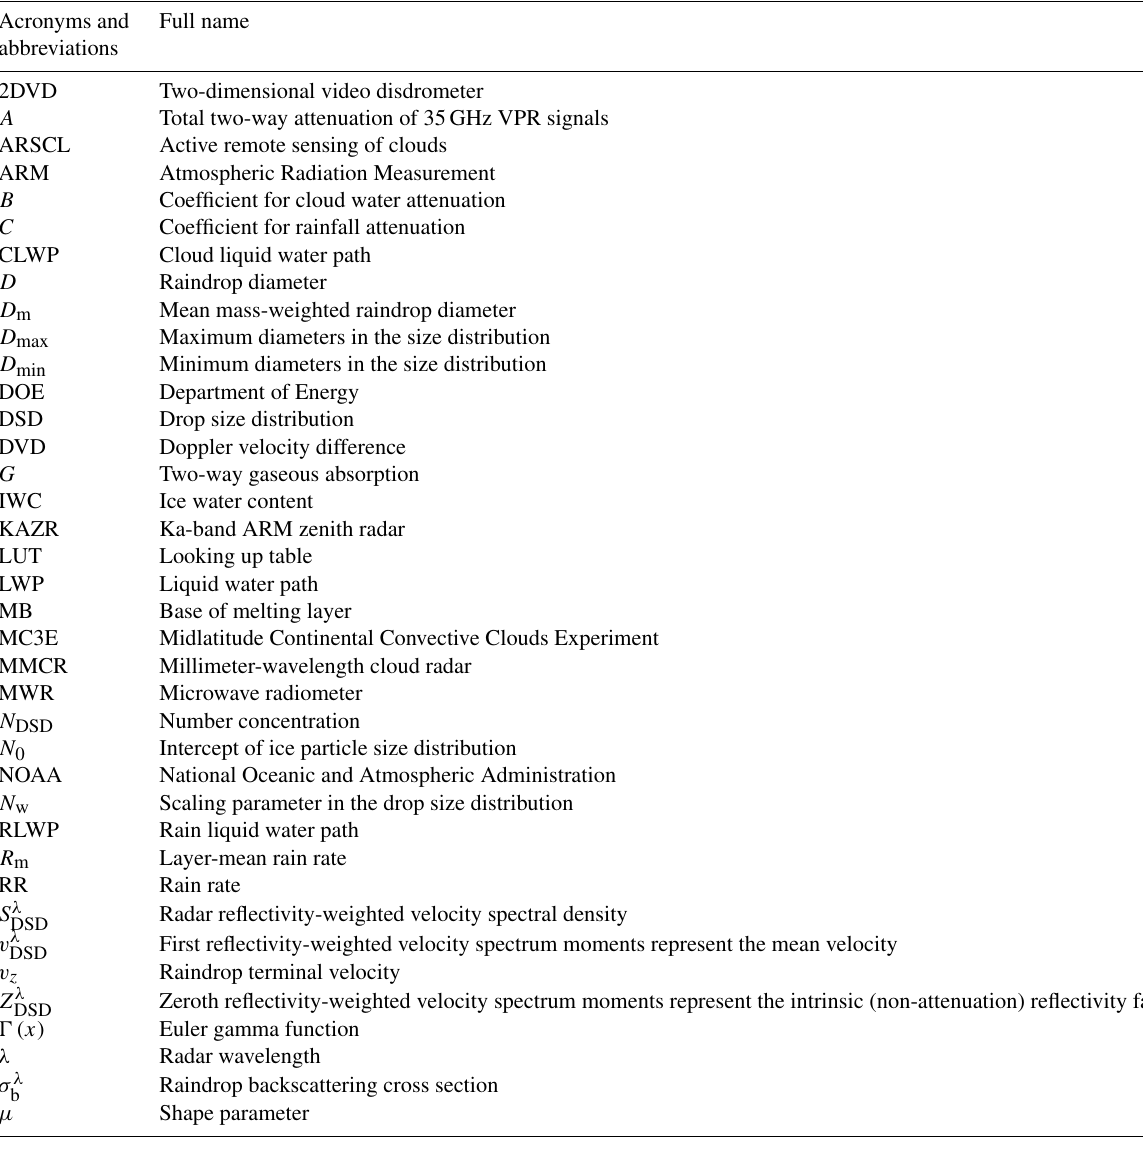
Table 1. Acronyms and abbreviations used in this